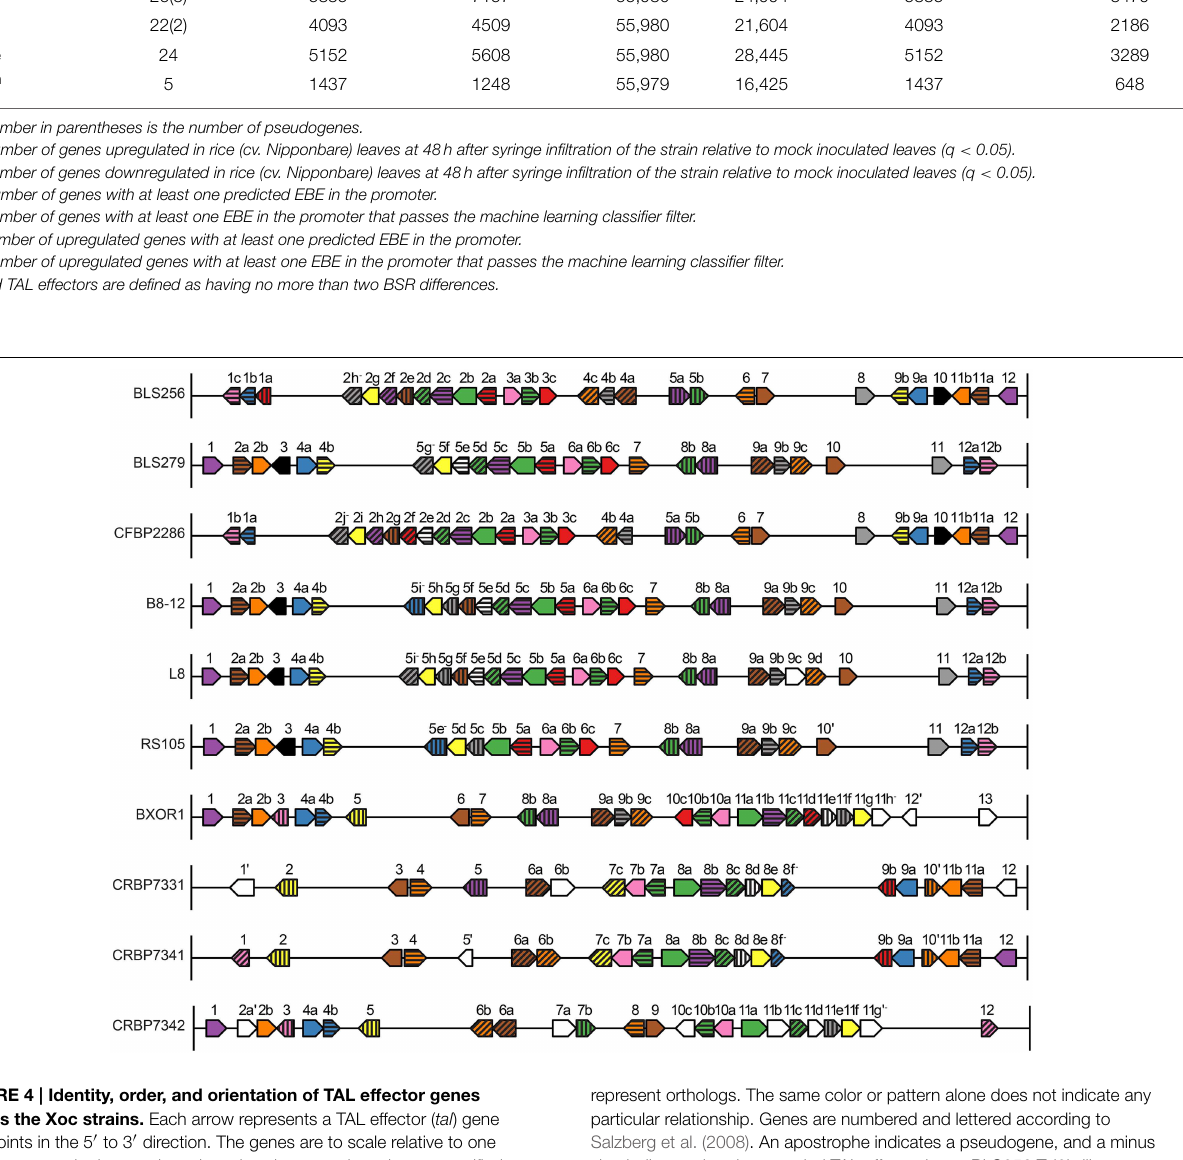
represent orthologs. The same color or pattern alone does not indicate any particular relationship. Genes are numbered and lettered according to Salzberg et al. (2008). An apostrophe indicates a pseudogene, and a minus sign indicates that the encoded TAL effector has a BLS256 Tal2h-like C-terminus, lacking the activation